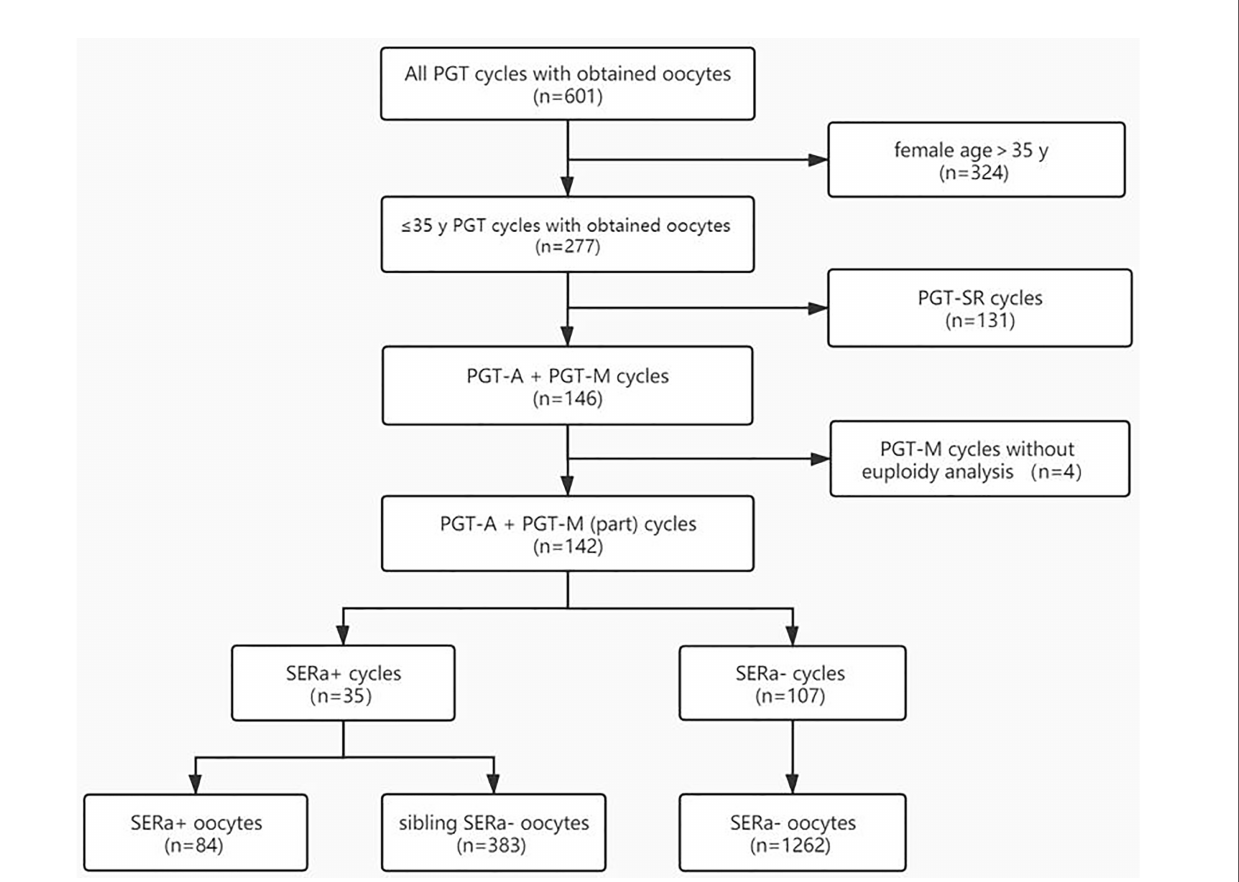
FIGURE 2 | Flowchart. PGT-SR, PGT for chromosomal structural rearrangements; PGT-A, PGT for aneuploidy; PGT-M, PGT for monogenic defects; SERa, smooth endoplasmic reticulum aggregation.